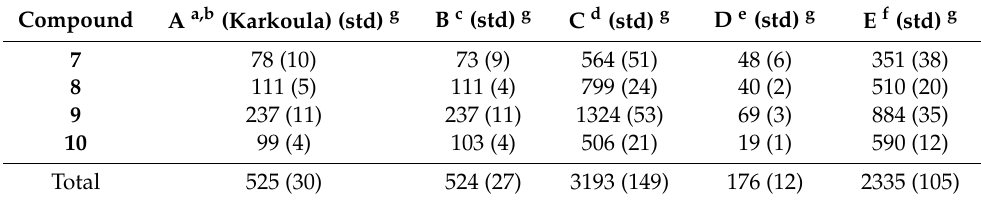
Table 2. Quantification of compounds 7 – 10 with different extraction methods by q NMR.